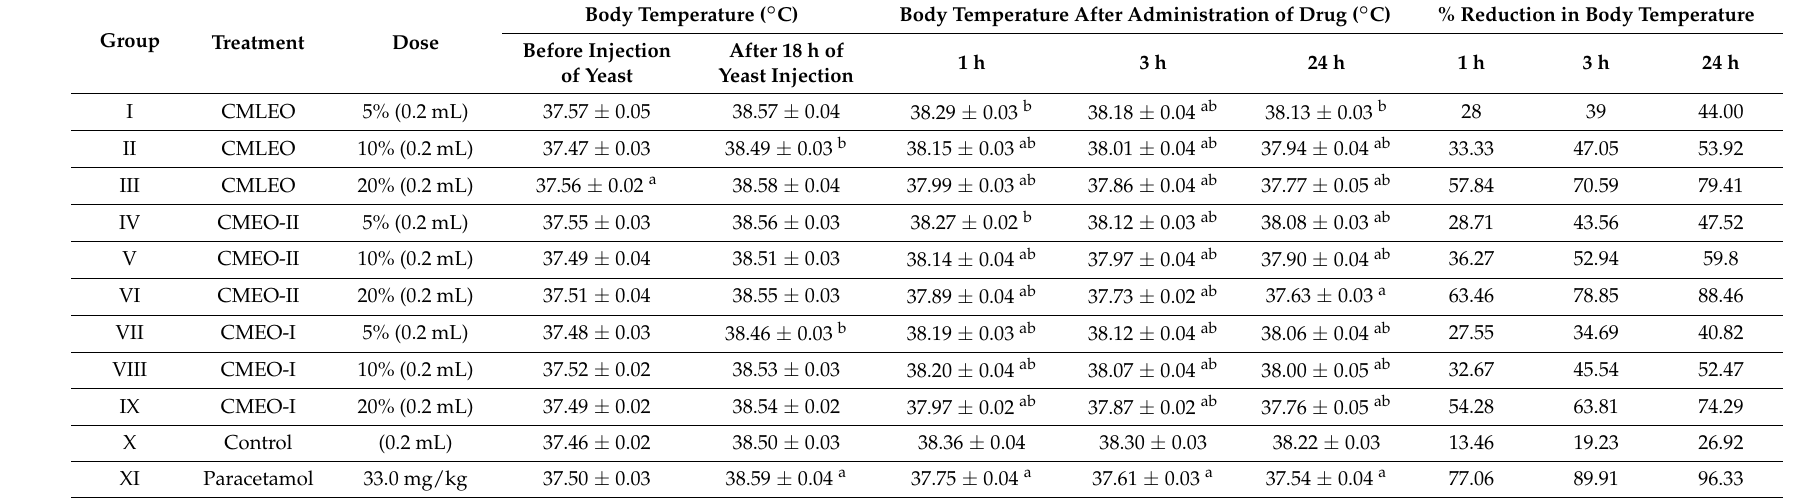
Table 6. Effect of essential oils from C. macrophylla on brewer’s yeast-induced pyrexia in